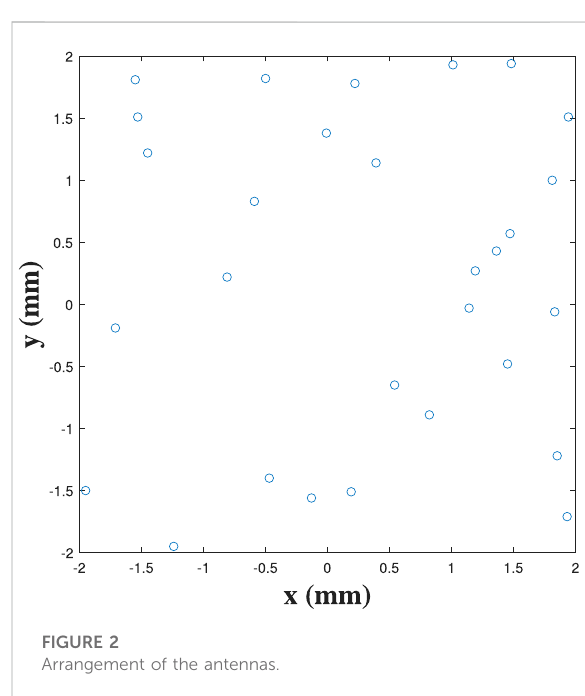
FIGURE 2 Arrangement of the